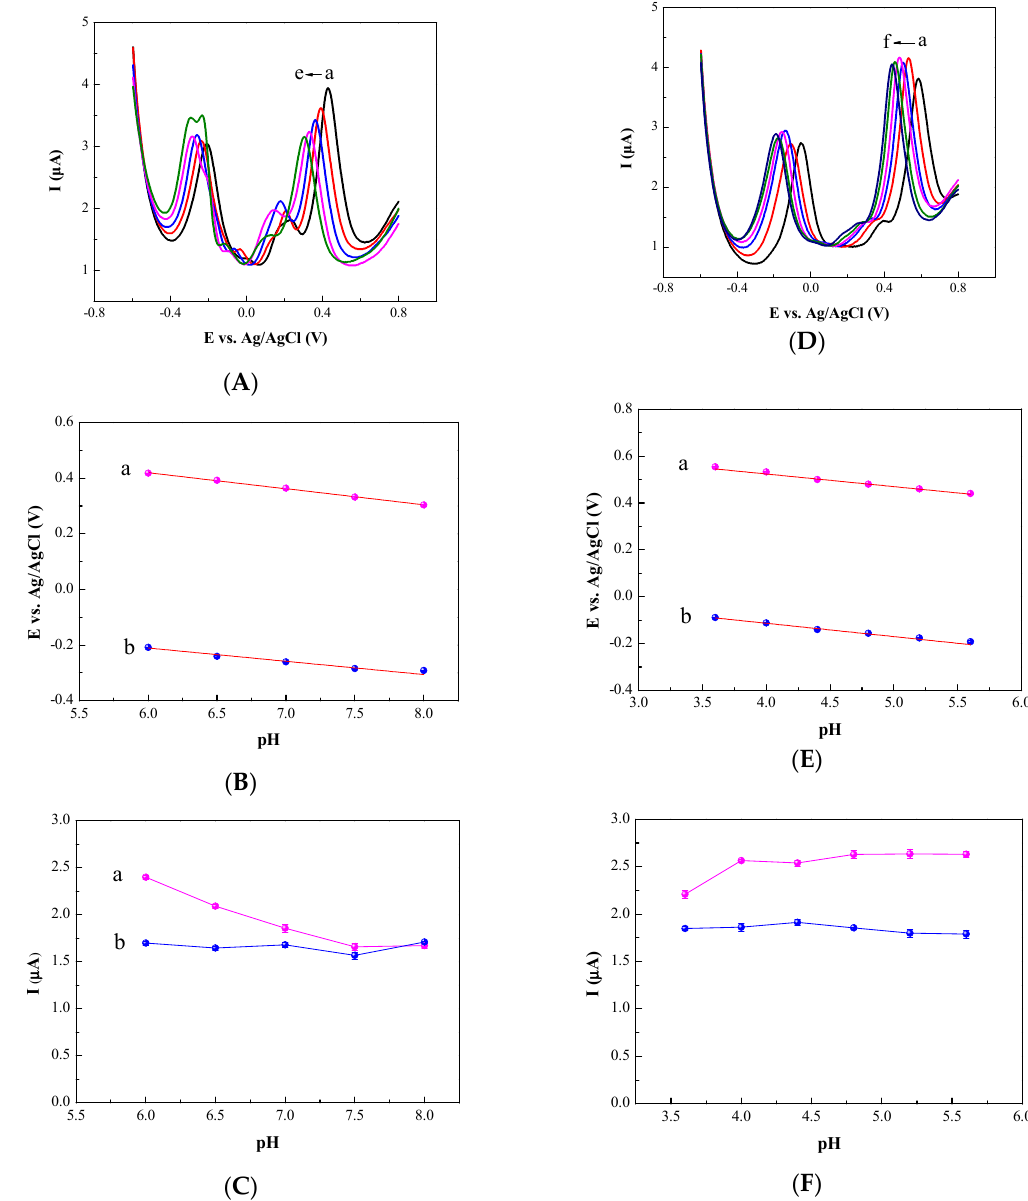
Figure 3. ( A ) SWV curves of 75 µ M CBL and 5 µ M NB in PBS with various pH value: (a) 6.0; (b) 6.5; (c) 7.0; (d) 7.5; (e) 8.0; ( B ) plots of peak potential and pH value in PBS (a) CBL, (b) NB. ( C ) Plots of peak current and pH value (a) CBL, (b) NB. ( D ) SWV curves of 75 µ M CBL and 5 µ M NB in acetate bu ff er solution (ABS) with various pH value: (a) 3.6; (b) 4.0; (c) 4.4; (d) 4.8; (e) 5.2; (f); 5.6. ( E ) Plots of peak potential and pH value in PBS (a) CBL, (b) NB. ( F ) Plots of peak current and pH value in ABS (a) CBL, (b) NB.